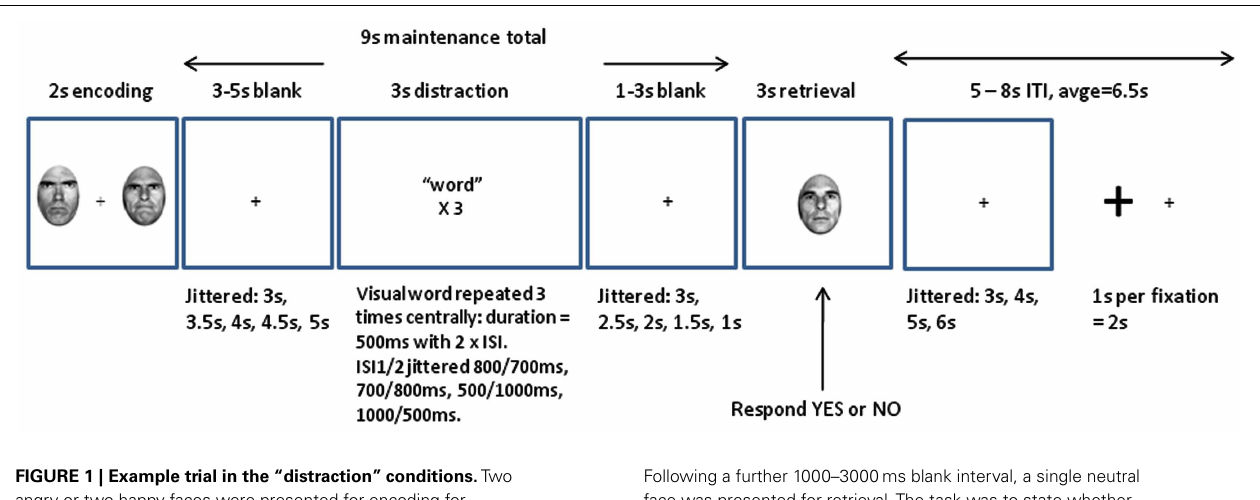
FIGURE 1 | Example trial in the “distraction” conditions. Two angry or two happy faces were presented for encoding for 2000ms, and 3000–5000ms into theWM maintenance period a “distracter” word was flashed three times for 500ms each time.